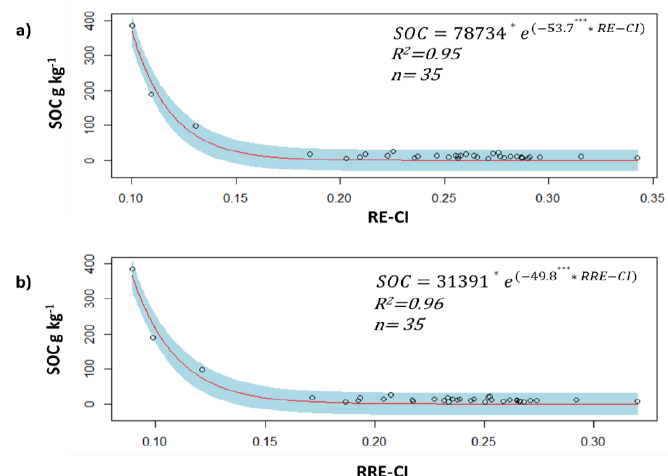
Figure 6. Exponential fitted models (red lines) for soil organic carbon (SOC) prediction using the Red-Edge Carbon Index (RE-CI) ( a ), and the Red-Red-Edge Carbon Index (RRE-CI) ( b ) index. The blue area represents the prediction limits. The black circles represent the measured SOC values of the calibration dataset. Asterisks refer to the significance level: *** p -value < 0.01, * p -value < 0.05.